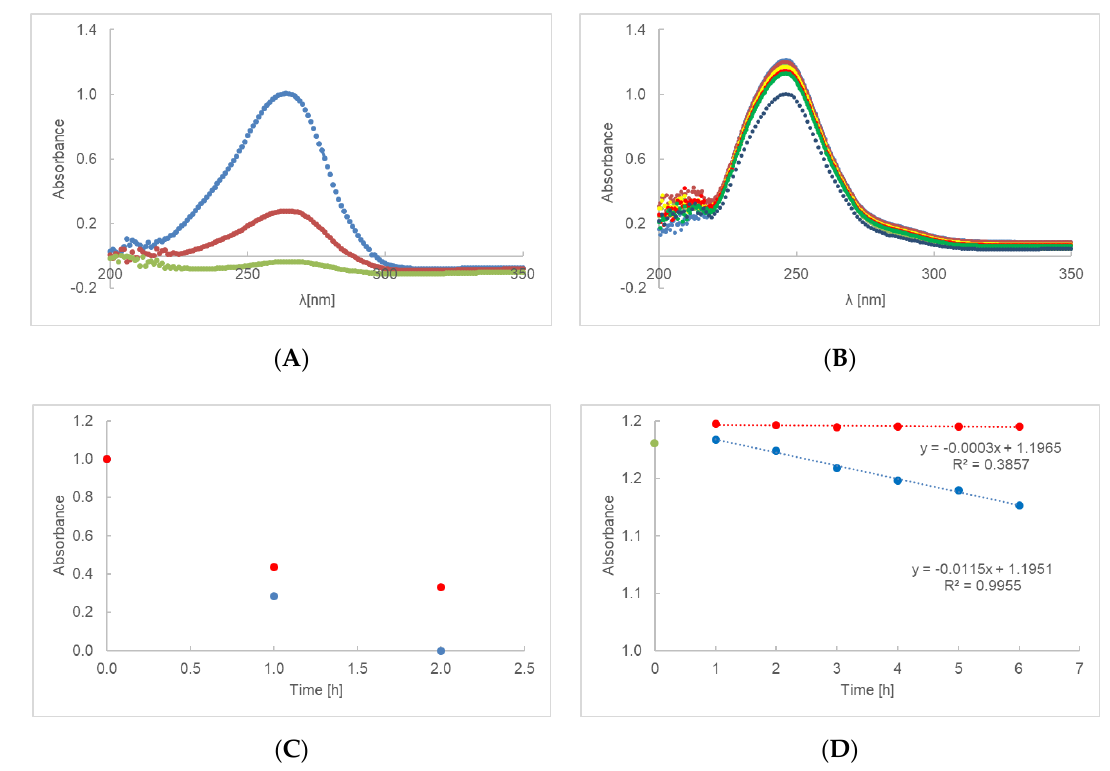
Figure 1. UV-Vis spectra of preparation AA-PA ( A ) and AE-PA ( B ), irradiated at 0( – ), 1( – ),2( – ), 3( – ), 4( – ), 5( – ) and 6( – ) h. The UV degradation gel containing PA and ascorbic acid ( C ), or ethyl ascorbic acid ( D ), presented as time function of absorbance. Red dots represent unexposed samples and blue dots represent irradiated samples. During the first hour, the specimen stabilizes — green dot represents the starting point of the procedure on ( D ) graph.